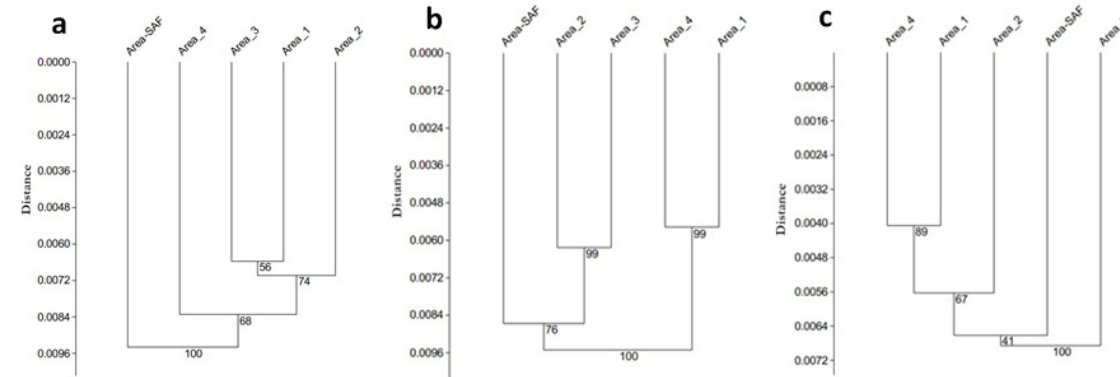
Fig 3 . Dendrogram UPGMA obtained from the average values of the shape. (a) Euglossa cordata , with cophenetic correlation of 95%; (b) Euglossa ignita with cophenetic correlation of 86%, (c) Eulaema atleticana, cophenetic correlation of